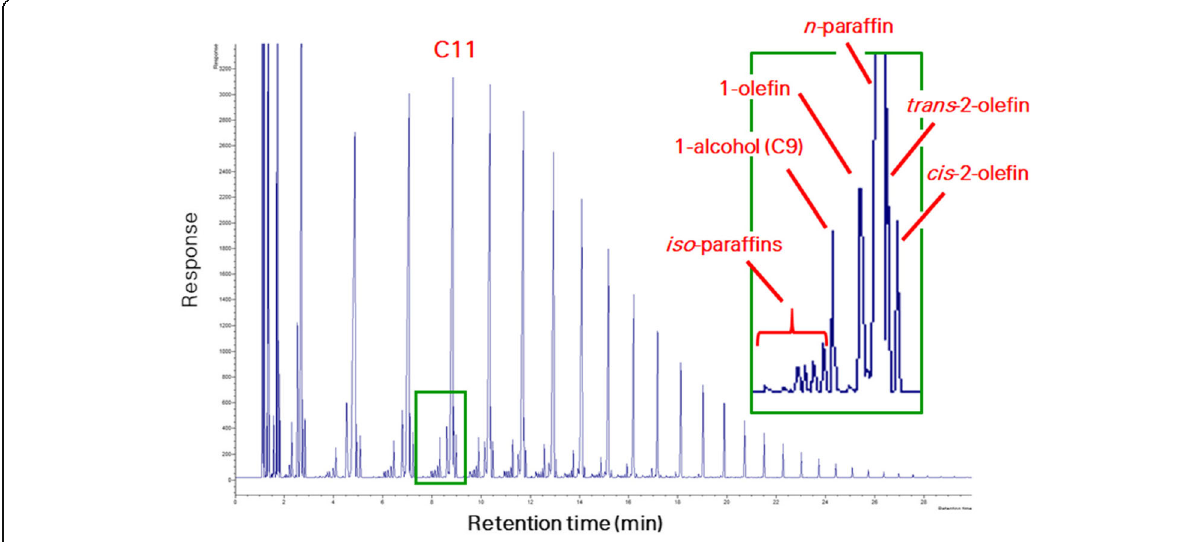
Fig. 3 1D GC analysis of light hydrocarbon,